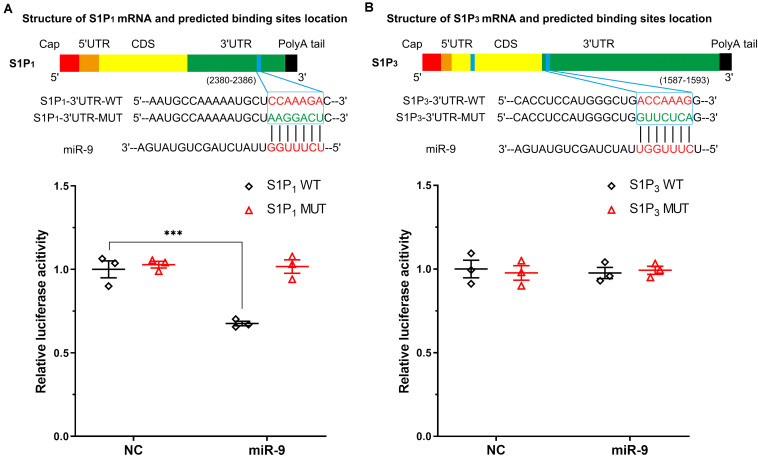
Associations between S1P1, S1P3, and miR-9 were detected by dual-luciferase reporter assay. The structures of S1P1 mRNA (transcript variant 1 M_001400.5, and transcript variant 2 NM_001320730.1; the variant 2 differs in the 5′UTR compared to variant 1, both variants 1 and 2 encode the same protein) and S1P3 mRNA (NM_005226.4) including coding DNA sequence (CDS) and untranslated regions were depicted. The blue band indicated the putative miR-9 binding sequence in the target mRNA molecules. The binding sites located at 3′UTR were screened for Dual-Luciferase Reporter Assay analysis. (A) Putative wild-type (WT) binding sequence and its mutation (MUT) sequence in the 3′UTR of S1P1. Luciferase activity was measured. (B) Putative WT binding sequence and its MUT sequence in the 3′UTR of S1P3. Luciferase activity was measured. NC: miR-9 mimics negative control. Mean ± SEM. n = 3, ***P < 0.001.